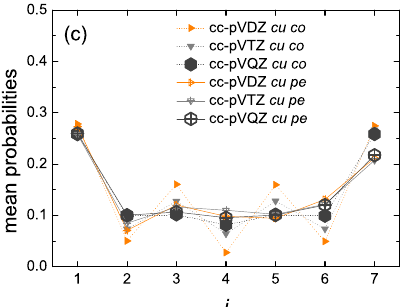
Figure 14. Site occupations, i.e., mean over time probabilities to find the hole at site j , for initial placement of the hole at the first site, for N = 7, obtained by Real-Time Time-Dependent Density Functional Theory (RT-TDDFT) [3-21G (pink left triangles), 6-31G* (red up triangles), cc-pVDZ (orange right triangles), cc-pVTZ (gray down triangles), cc-pVQZ (dark gray hexagons)] and the functional B3LYP, as well as by TB wire model variants [TBI (black squares), TBImod (green pentagons), TBImodt4times (purple circles)]. ( a ) cumulenic molecules with coplanar methylene groups ( cu co ), ( b ) cc-pVTZ/B3LYP for cu co molecules versus polyynic molecules starting with short or long bonds ( po sl or po ls ). Half-filled down triangles for po sl (blue filled right) and po ls (purple filled left). ( c ) cu co versus cumulenic molecules with perpendicular methylene groups ( cu pe ) for the 3 larger basis sets. Dotted lines are guides to the eyes.